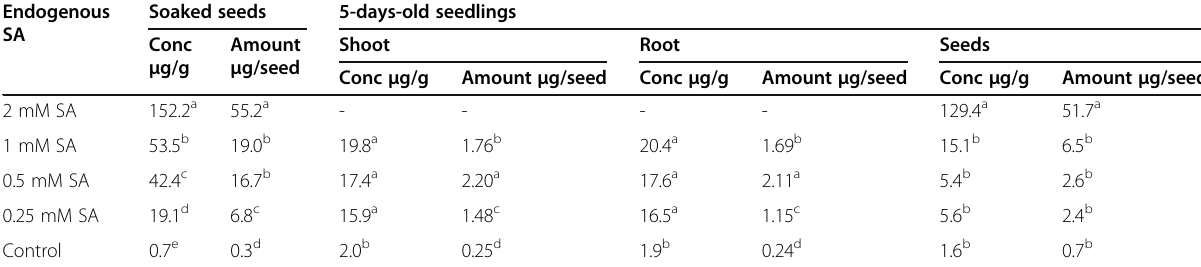
Table 1 Effect of pre-soaking maize seeds in SA for 48 hours on concentration and distribution of endogenous SA in soaked seeds and 5-days-old